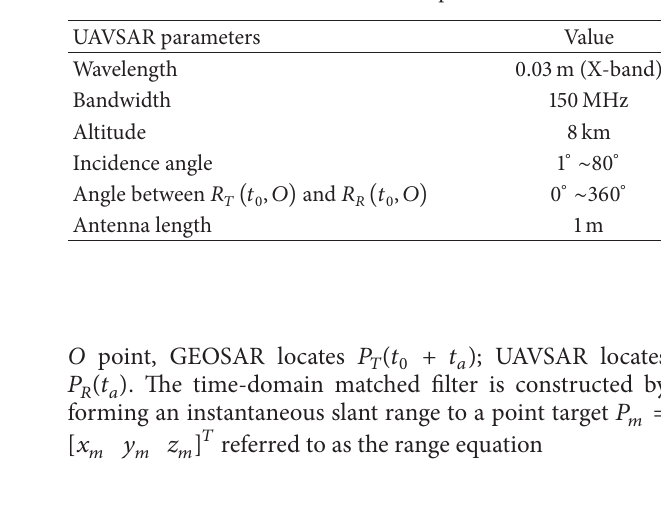
Table 2: UAVSAR receiver